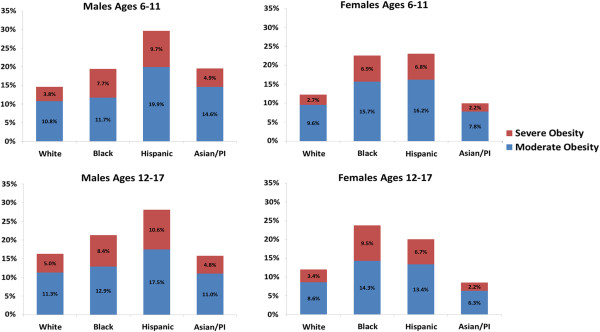
The proportion of children and adolescents with moderate and severe obesity by age, sex and race/ethnicity. Comparisons by race/ethnicity within each age-sex group showed that the prevalence of obesity (BMI ≥95th percentile) was significantly different between all racial/ethnic subgroups (p < 0.01) except for differences in obesity prevalence for black vs Asian 6–11 year old boys (p = 0.90), black vs. Hispanic 6–11 year old girls (p = 0.64), and white vs. Asian 12–17 year old boys (p = 0.37). The prevalence of severe obesity (BMI ≥120% of the 95th percentile) was also significantly different between all racial/ethnic subgroups (p < 0.01), except for white vs. Asian (p = 0.06) and black vs. Hispanic 6–11 year old girls (p = 0.96), and white vs. Asian 12–17 year old boys (p = 0.58).